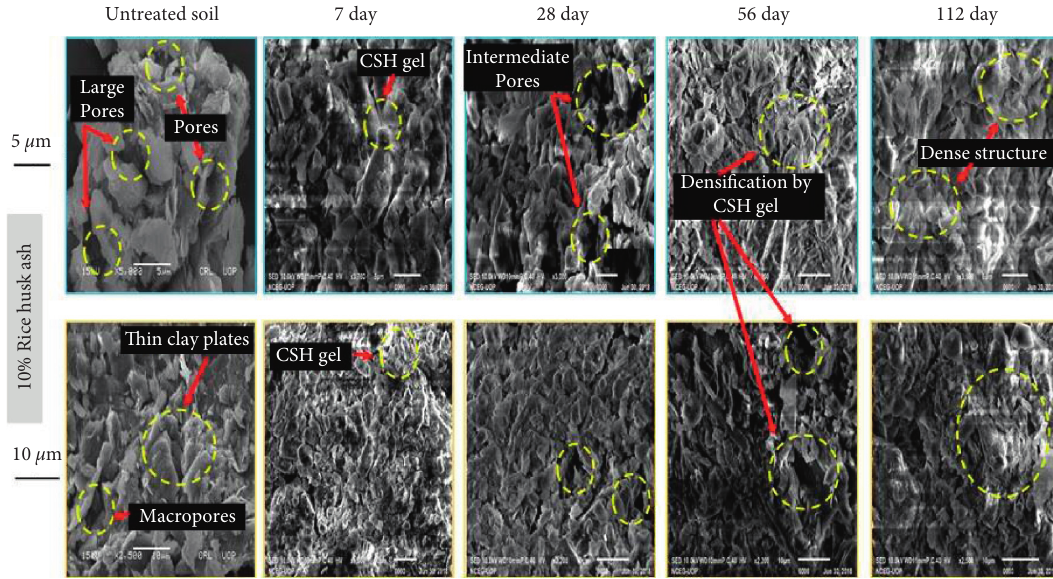
Figure 14: SEM micrographs of untreated expansive soil and 10% RHA-blended soil samples cured at 7, 28, 56, and 112